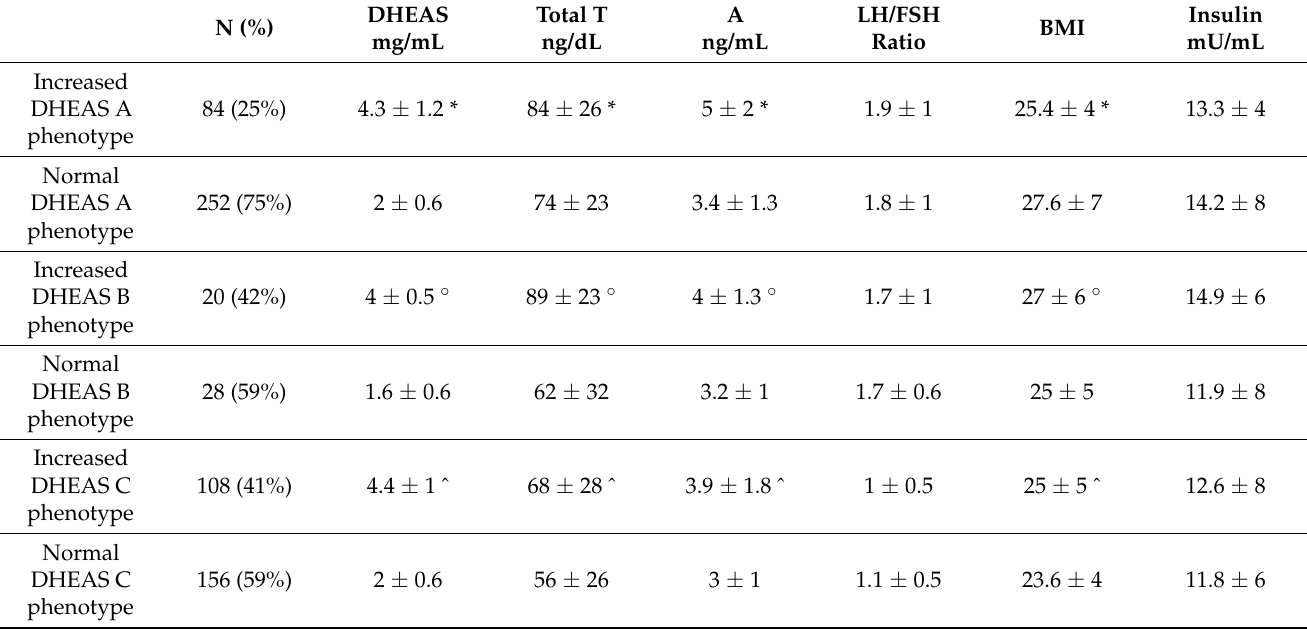
Table 3. Serum androgens and some other hormonal values in patients of the three hyperandrogenic phenotypes of women with PCOS, divided according to their DHEAS serum